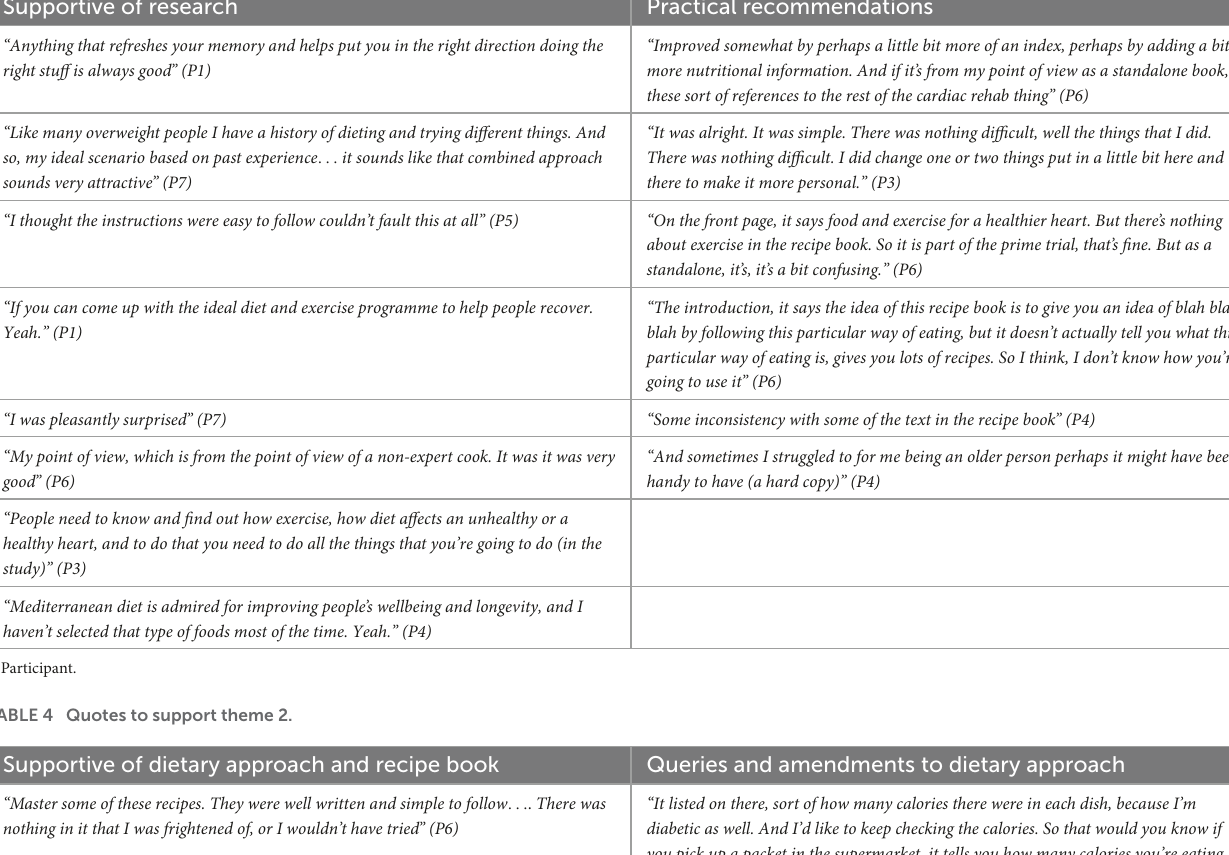
TABLE 4 Quotes to support theme